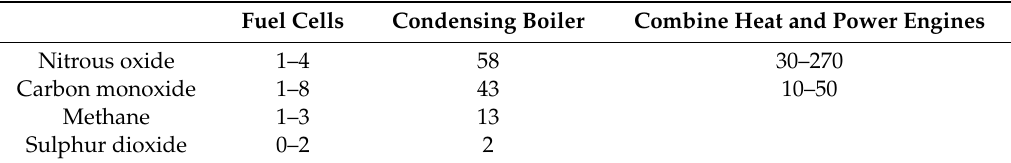
Table 3. Emissions from fuel cells in comparison to condensing boilers and combined heat and power engines